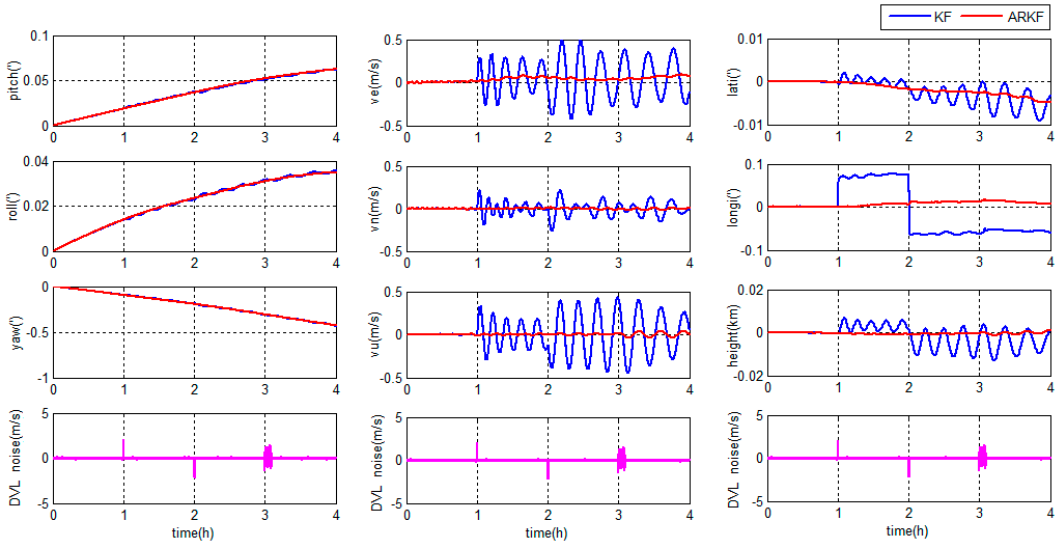
Figure 13. Integrated navigation errors in the middle latitude regions.